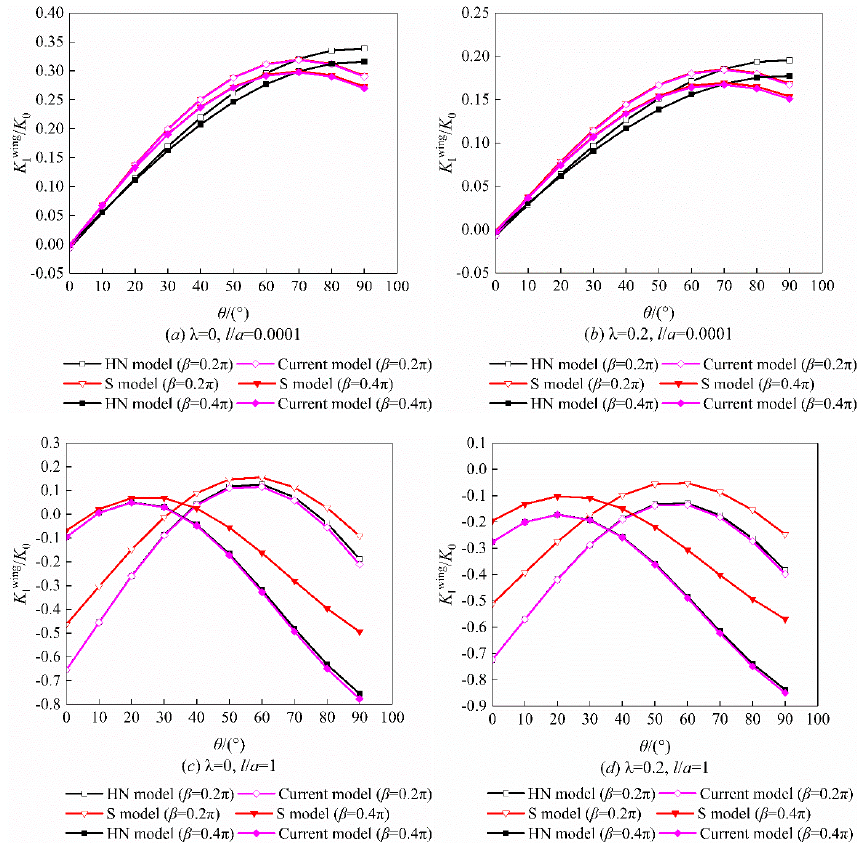
Figure 4. Stress intensity factors computed by different models; ( a ) λ =0, l / a =0.0001; ( b ) λ =0.2, l / a =0.0001; ( c ) λ =0, l / a =1; ( d ) λ =0.2, l/a =1. (1) Main crack inclination angle β : 0.2 π and 0.4 π